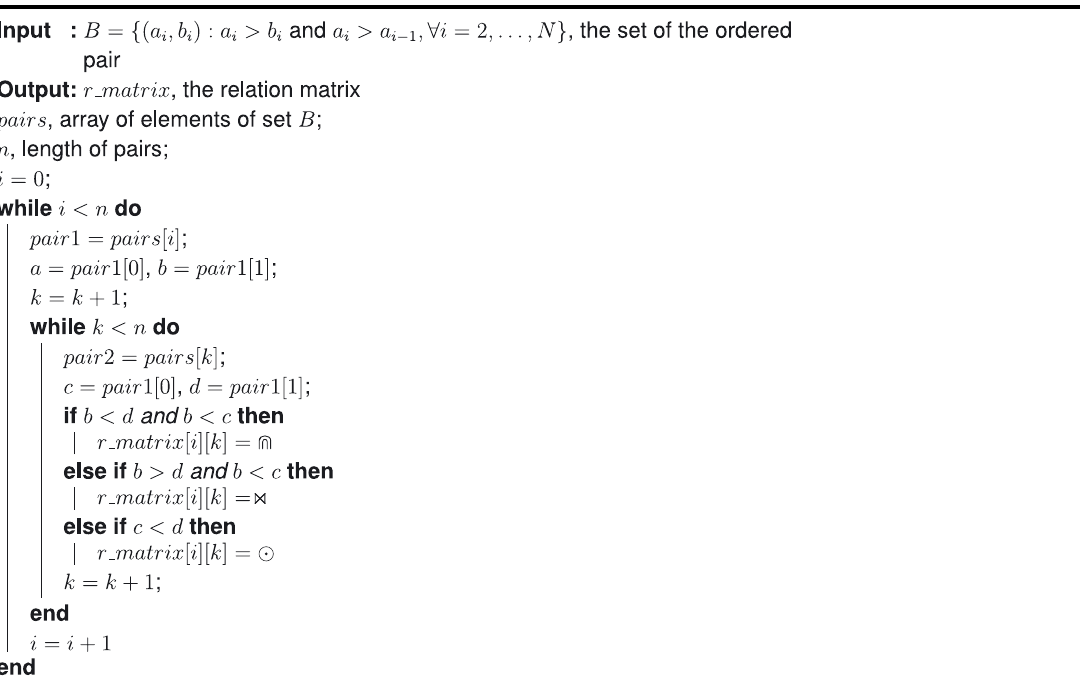
Algorithm 3: Determination of the relation